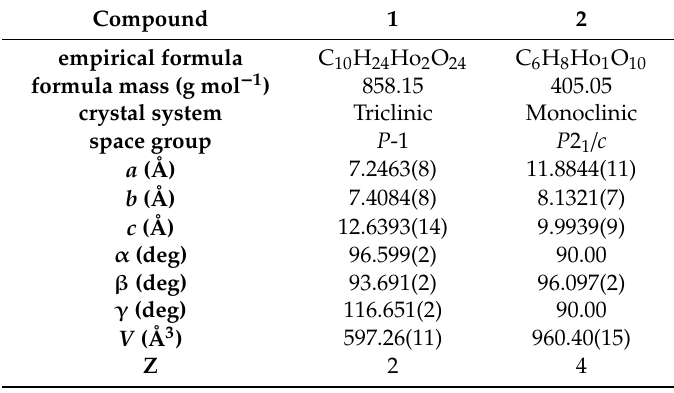
Table 1. Crystal data and refinement details of compounds 1 and 2